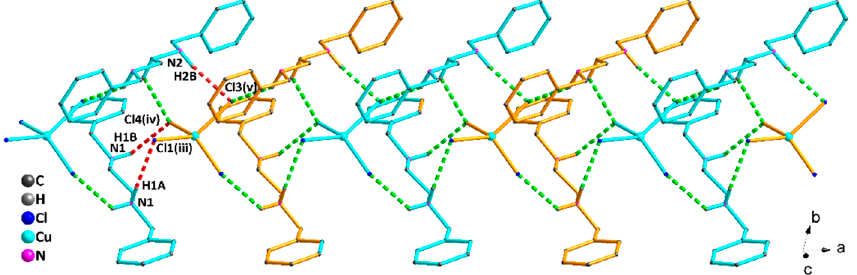
Figure 4. The 1D chain structure of compound ( 2 ). Symmetry codes: (iii) 1 − x,-y,1 − z; (iv) 1+x,y,z; (v) 1 − x,1 − y,1 − z.